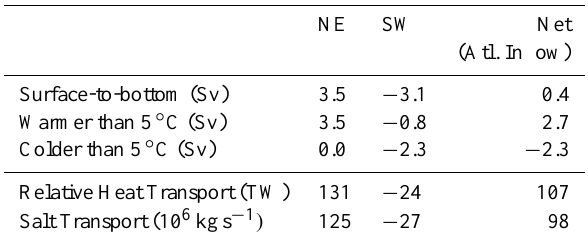
Table 5a. Average volume, heat (relative to 0 ◦ C) and salt trans- ports (positive towards the Norwegian Sea) through the FSC to- wards northeast (NE, positive) and southwest (SW, negative), as well as their difference (net) averaged over the 1995–2009 period (all using core interpolation scheme). All transports are based on geostrophic profiles (see text) and calculated from standard station 3 at the Faroese shelf edge to station 15 at 150m bottom depth on the Shetland side. Transports of relative heat and salt were calcu- lated only for the Atlantic water (i.e. warmer than 5 ◦